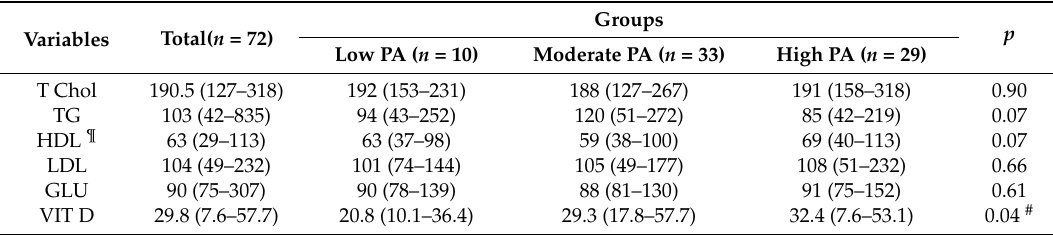
Table 2. Participant blood values at different PA levels.